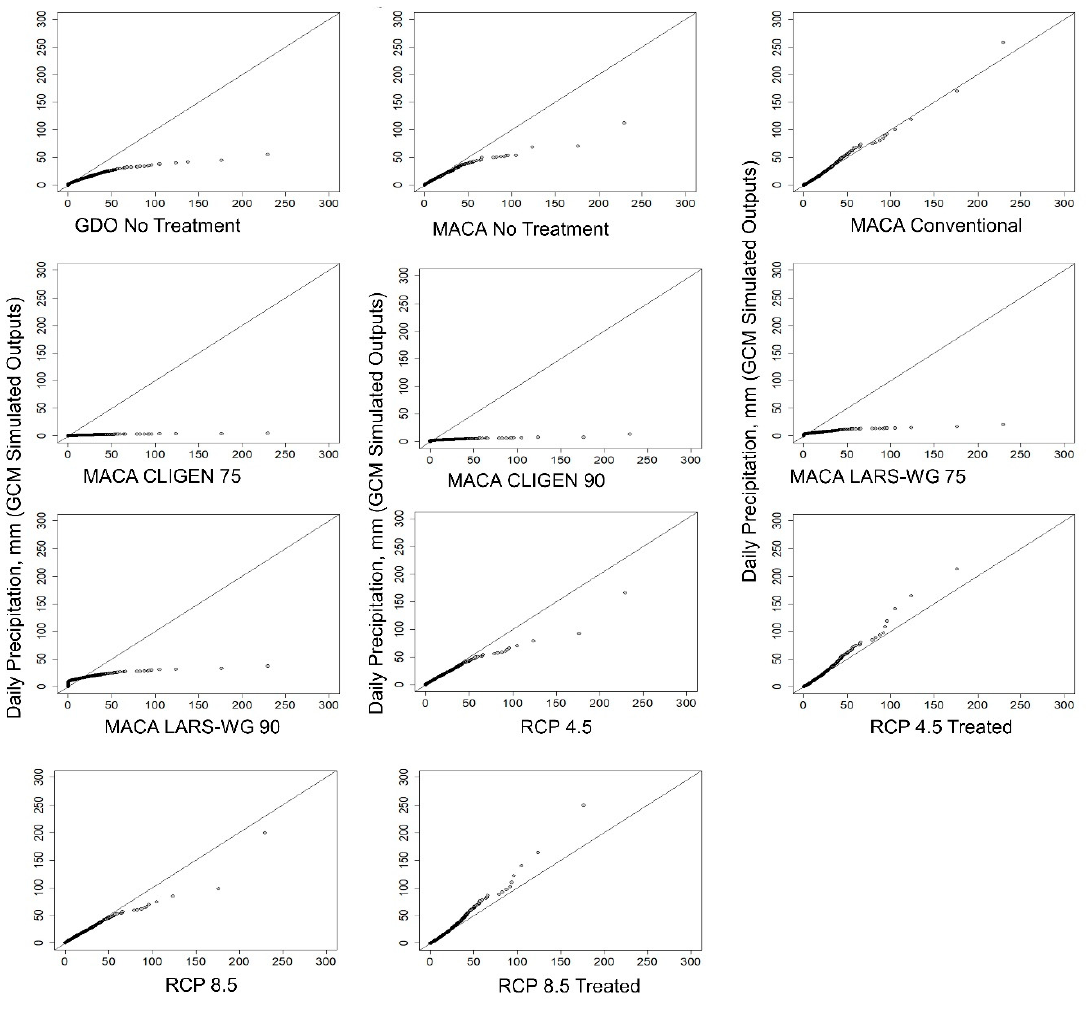
Figure 7. Q-Q plots to evaluate the performance of different bias correction methods for period between 1966 and 2005 to reduce the bias in simulating values for daily precipitation, mm and to present the future climatic scenarios (2006–2099) for Norwalk, OH.